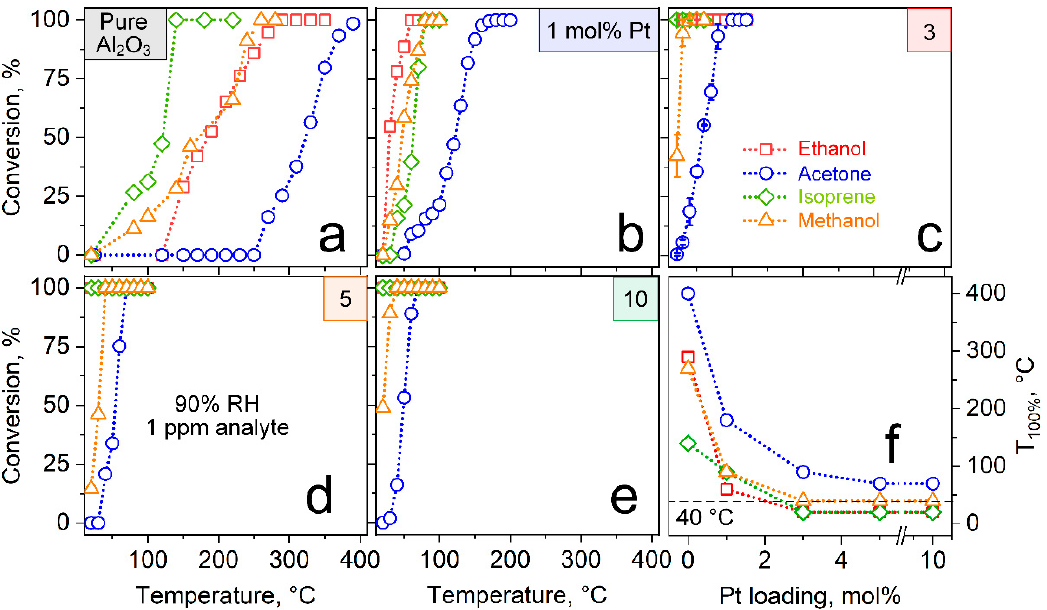
Figure 3. Conversion of 1 ppm ethanol (squares), acetone (circles), isoprene (diamonds) and methanol (triangles) over pure Al 2 O 3 ( a ) and with 1 ( b ), 3 ( c ), 5 ( d ) and 10 mol% ( e ) Pt at 90% RH, as determined by PTR-ToF-MS. Error bars in ( c ) indicate the standard deviations for three identically prepared packed beds. ( f ) The corresponding temperature of complete conversion (T 100% ) as a function of Pt loading. Minimum required filter temperature (i.e., 40 ◦ C) to avoid water condensation in breath analysis is indicated as horizontal dashed